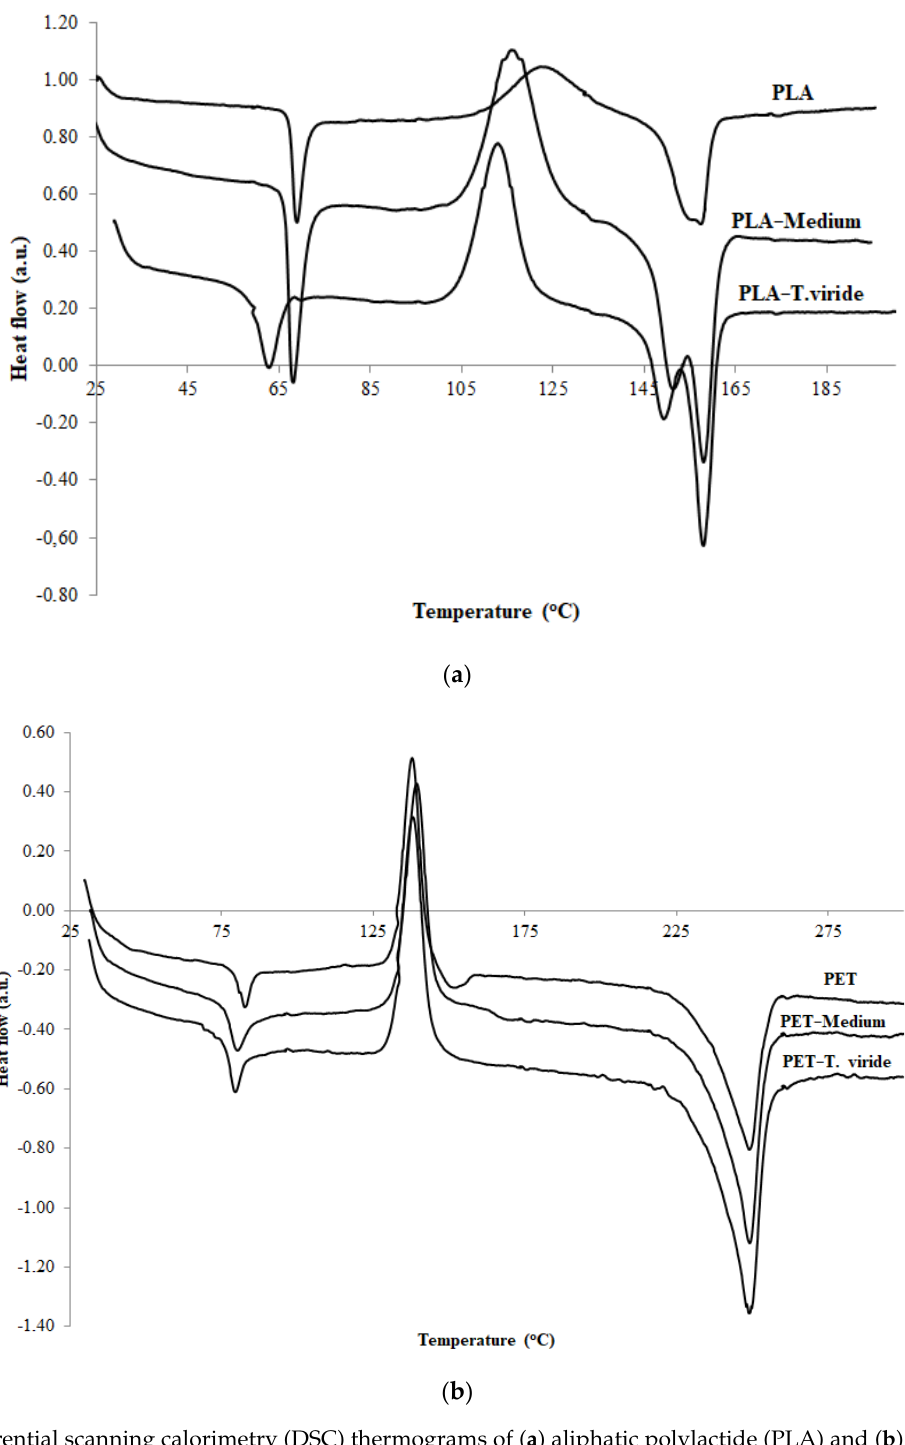
Figure 2. Differential scanning calorimetry (DSC) thermograms of ( a ) aliphatic polylactide (PLA) and ( b ) poly(ethylene terephthalate) (PET), before treatment (PLA/PET), after 3-month incubation in clean medium (PLA/PET − medium), and after 3-month incubation in medium containing T. viride GZ1 (PLA/PET − T. viride).